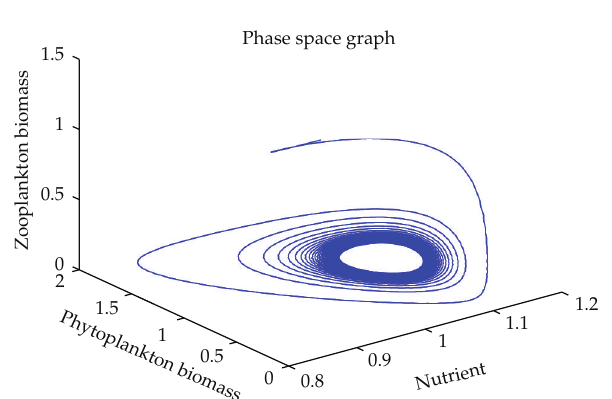
Figure 6: Phase-space diagram for nutrient, phytoplankton, and zooplankton at α (cid:7) 1 . 1, α 1 (cid:7) 0 . 07.